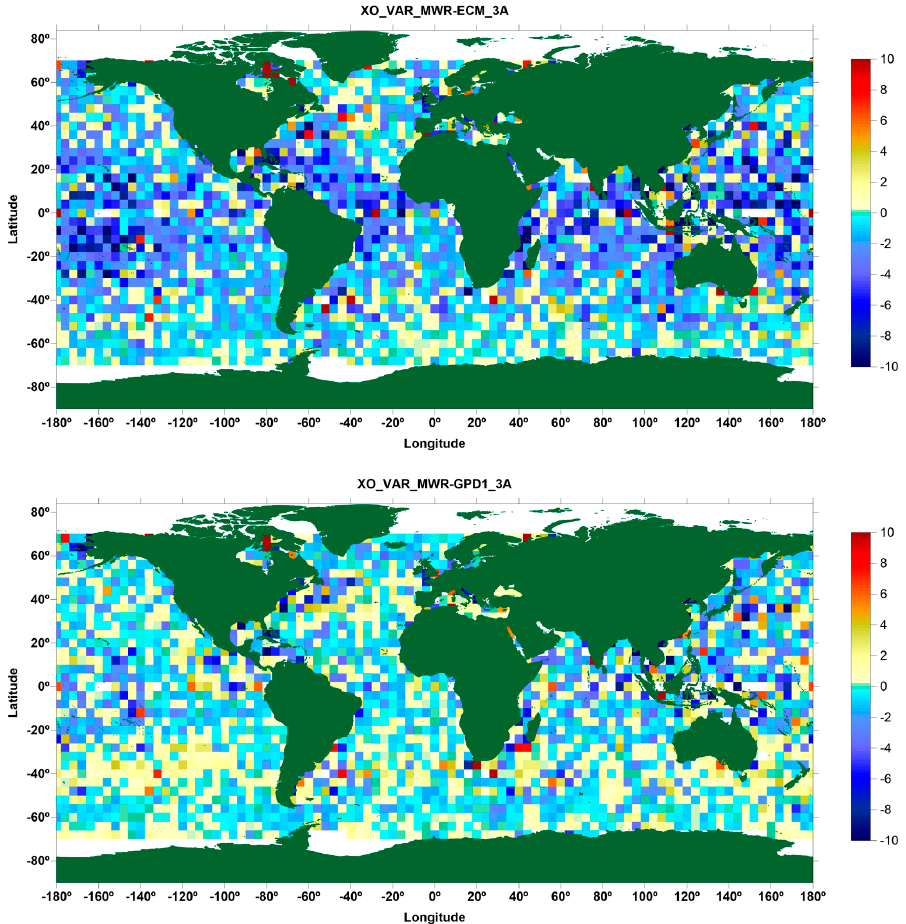
Figure 17. Spatial distribution of the weighted sea level anomaly (SLA) variance differences at crossovers, for SLA datasets computed using the MWR ‐ and ECMWF ‐ derived WTC ( Top ) and those using the WTC from the MWR and GPD1 ( Bottom ) for the period corresponding to S3A cycles 05 to 16. Only points with valid observations have been used.